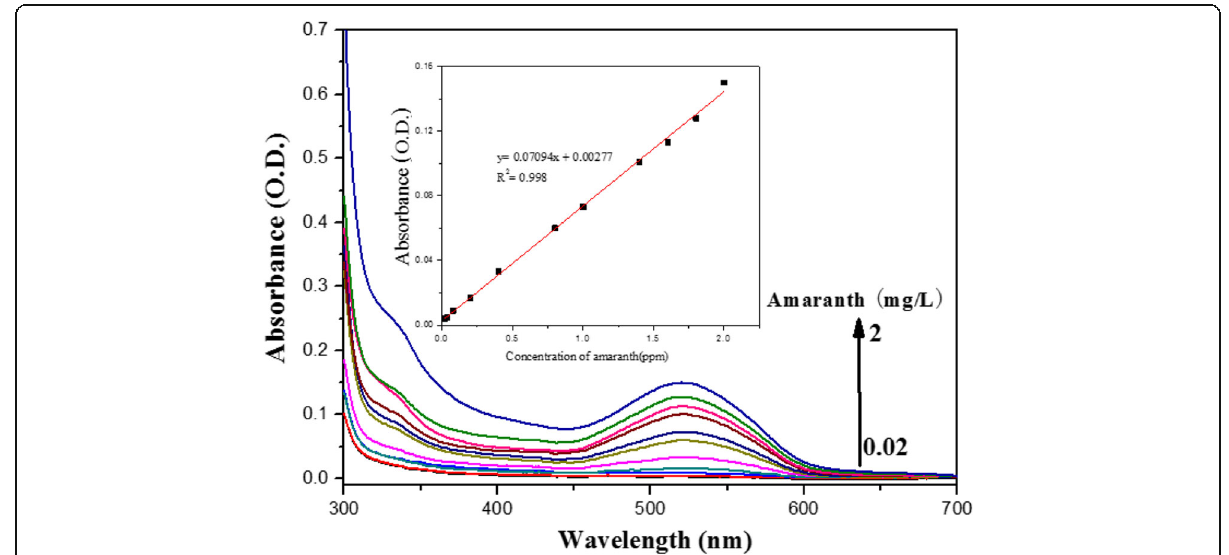
Fig. 5 UV-vis absorption spectra of the desorption solution of different concentrations of amaranth solution (inset: standard curve of concentration and absorbance)